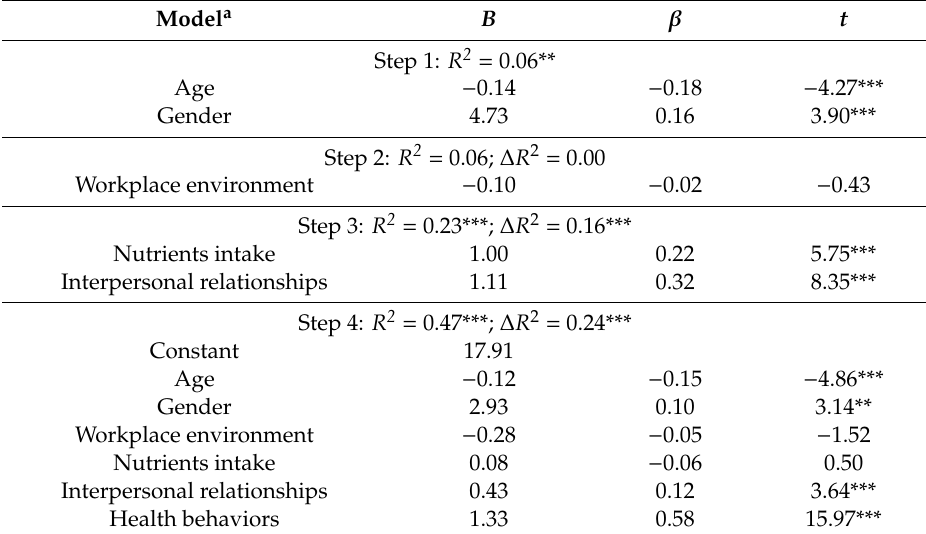
Table 3. Hierarchical regression analyses predicting physical